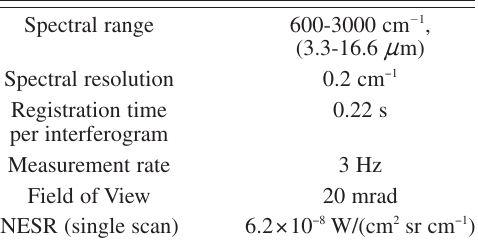
Table I. Technical data of the MIROR Fourier transform spectrometer.